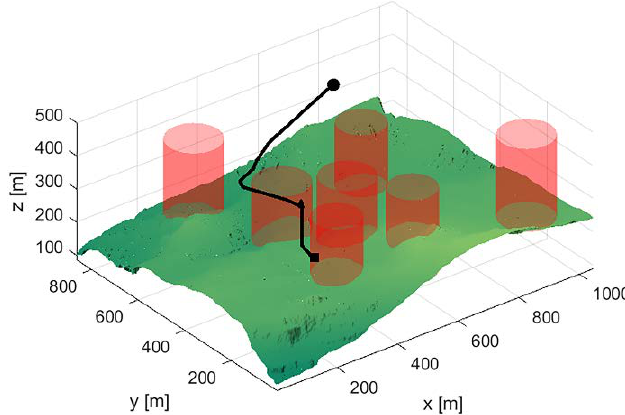
Figure 8. IC-VAINDIWPSO algorithm fitness function convergence graph (50 generations stop run- ning after convergence).